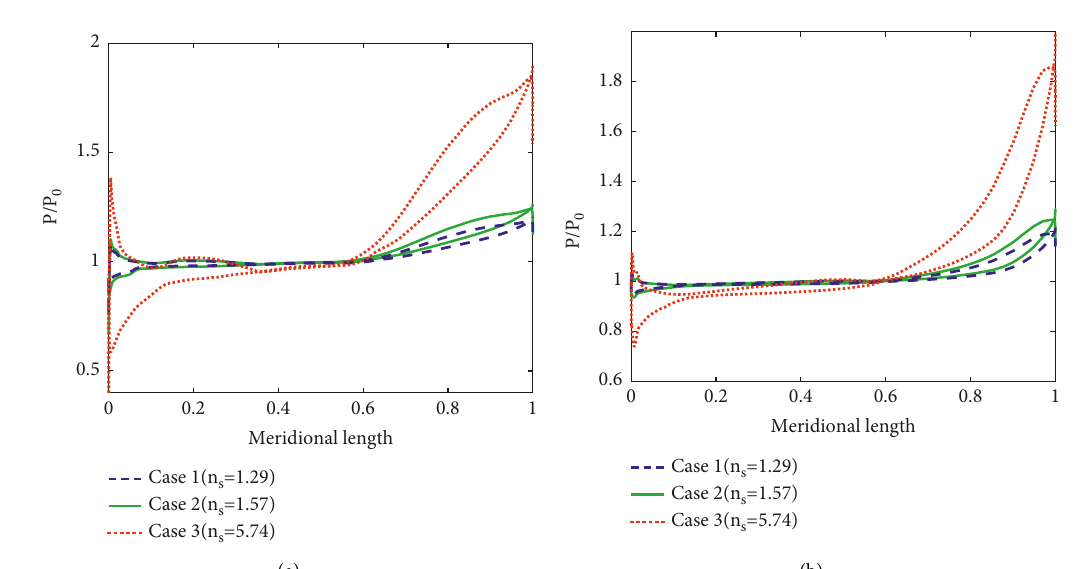
Figure 20: Dimensionless pressure along the impeller meridional direction. (a) At the span of 85%. (b) At the span of